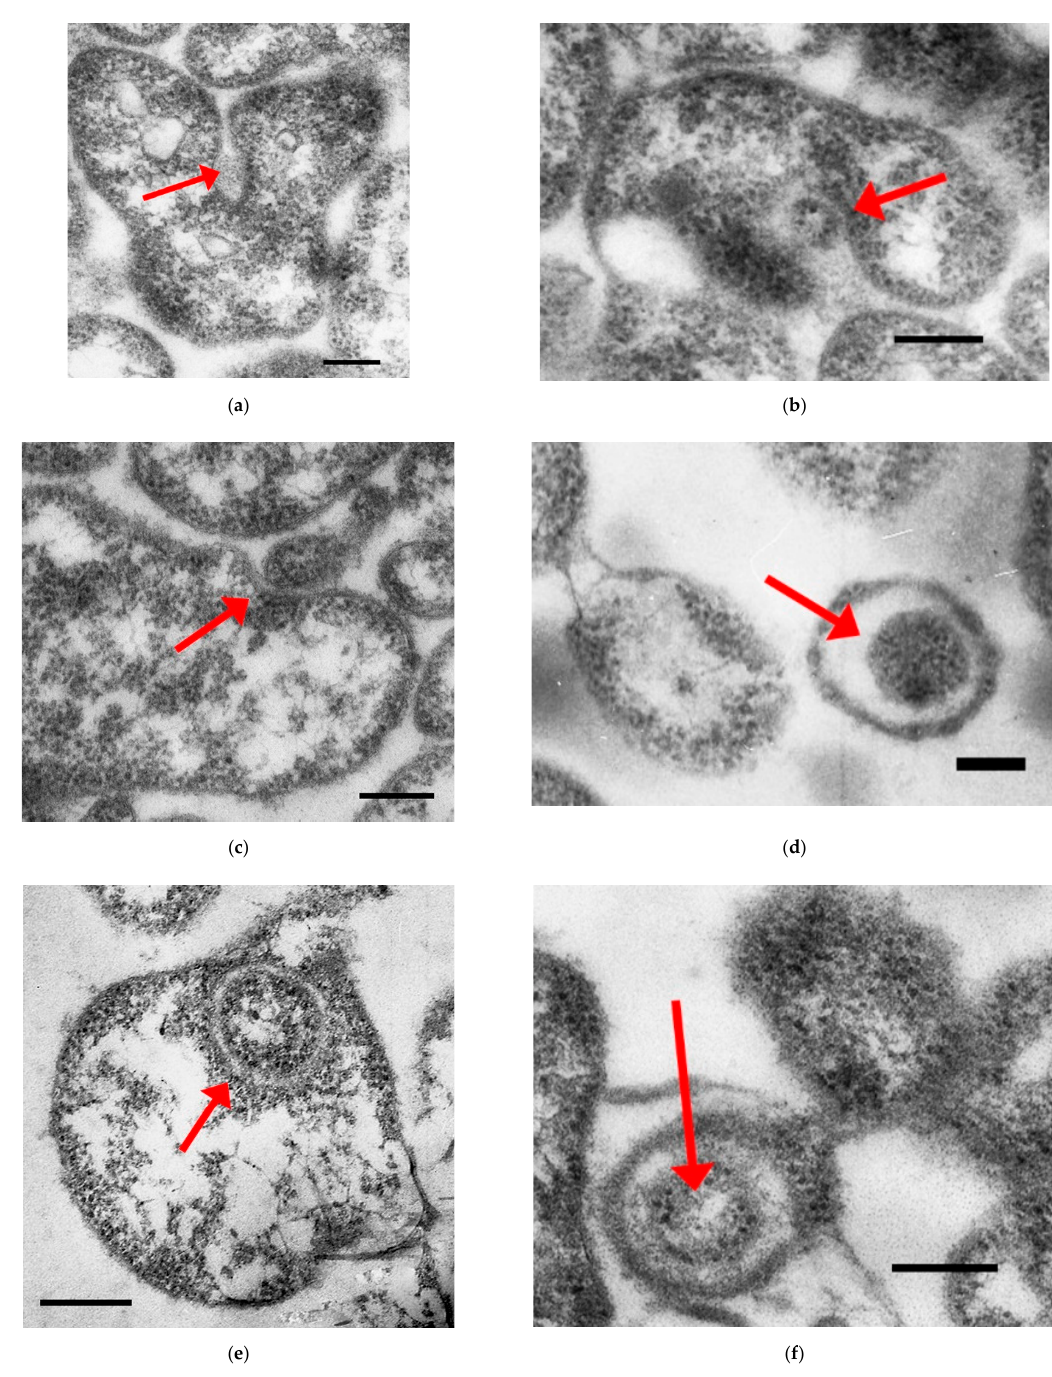
Figure 1. Electron microscopy images of Acholeplasma laidlawii PG8a cells. Red arrows point at ( a ) the probable membrane invagination and absorption of some material of low electron density but granular consistency; ( b ) the probable membrane invagination and absorption of a structure resembling the extracellular vesicles of A. laidlawii ; ( c ) an initial moment of the probable membrane invagination and absorption of a structure resembling the mini-bodies (mini-cells) of A. laidlawii ; ( d – f ) the probable cell-in-cell structures of A. laidlawii . Scale bars: 200